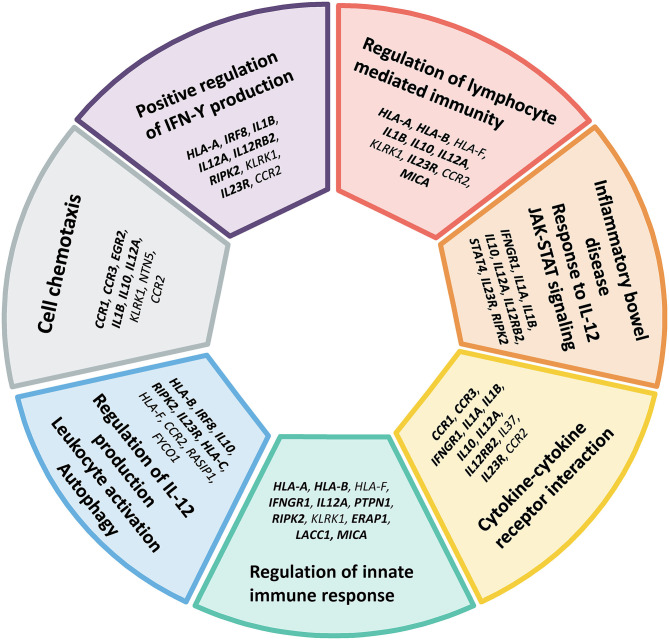
Main gene ontology and pathway clusters revealed by enrichment analysis of genes identified in the genetic studies of Behçet's disease. Both annotated genes (bold font) and candidate genes identified by functional enrichment and gene-gene interaction in this study (regular font) listed in Table 2 were included in the analysis. Only terms with p-value < 1 × 10−3 and at least three genes were considered.